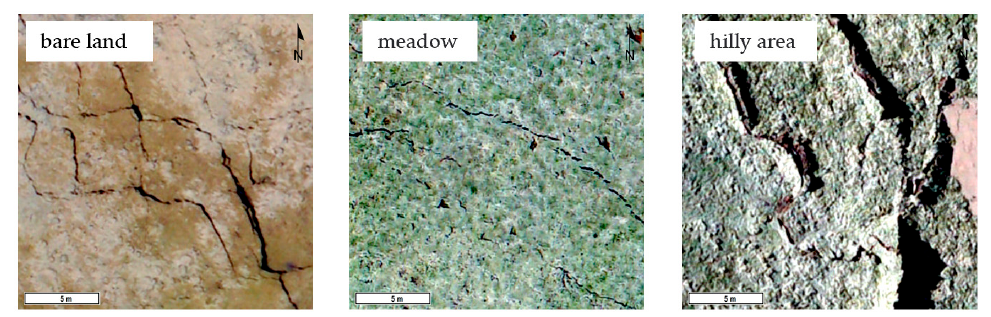
Figure 1. Topography of the study area.